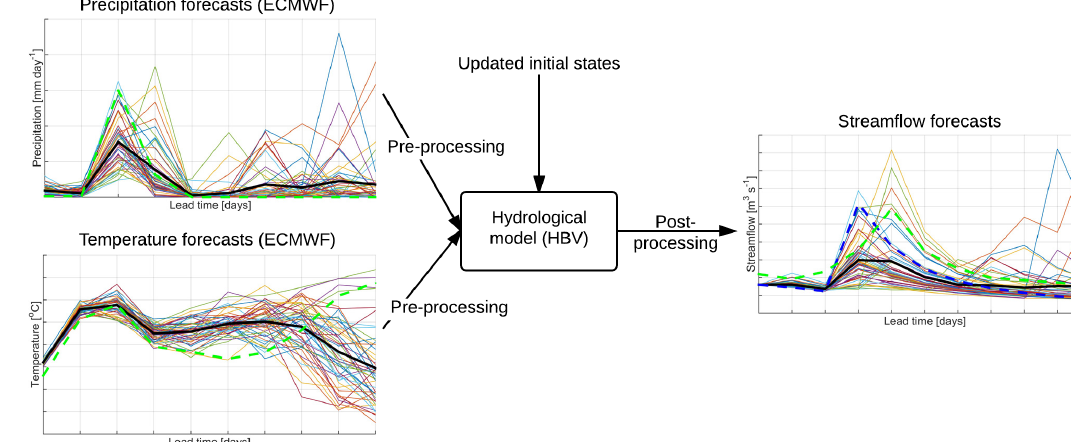
Figure 2. Structure of the ensemble streamflow-forecasting